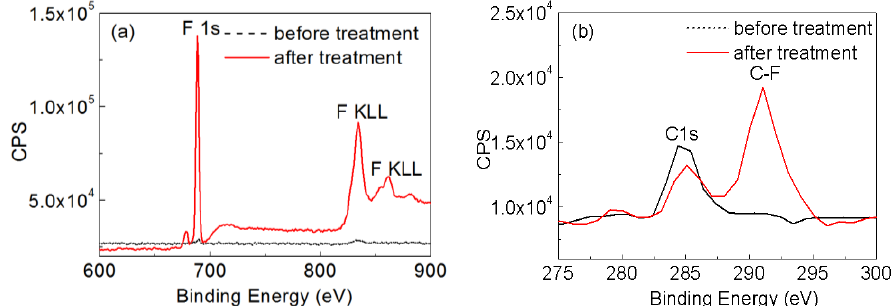
Figure 5. X-ray photoelectron spectroscopy (XPS) results for F ( a ) and C−F ( b ) of silica nanoparticles with treatment and without treatment by self-assembled monolayers of POTS.